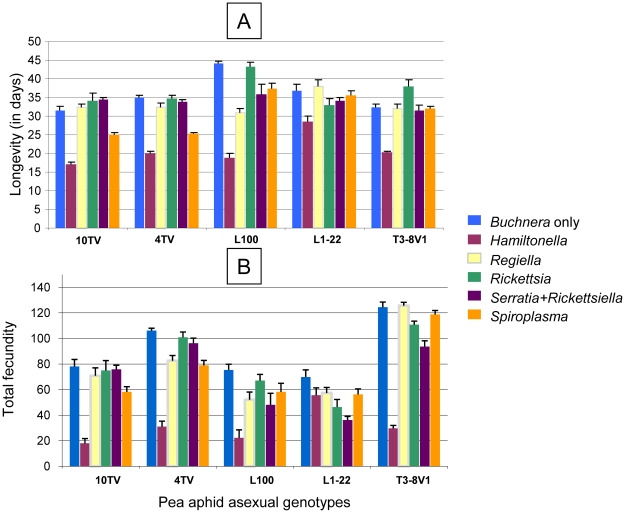
Influence of symbiont component on history traits of artificially infected lines of five asexual genotypes of the pea aphid exposed to standard conditions of sex induction (experiment 1).A) longevity and B) fecundity.